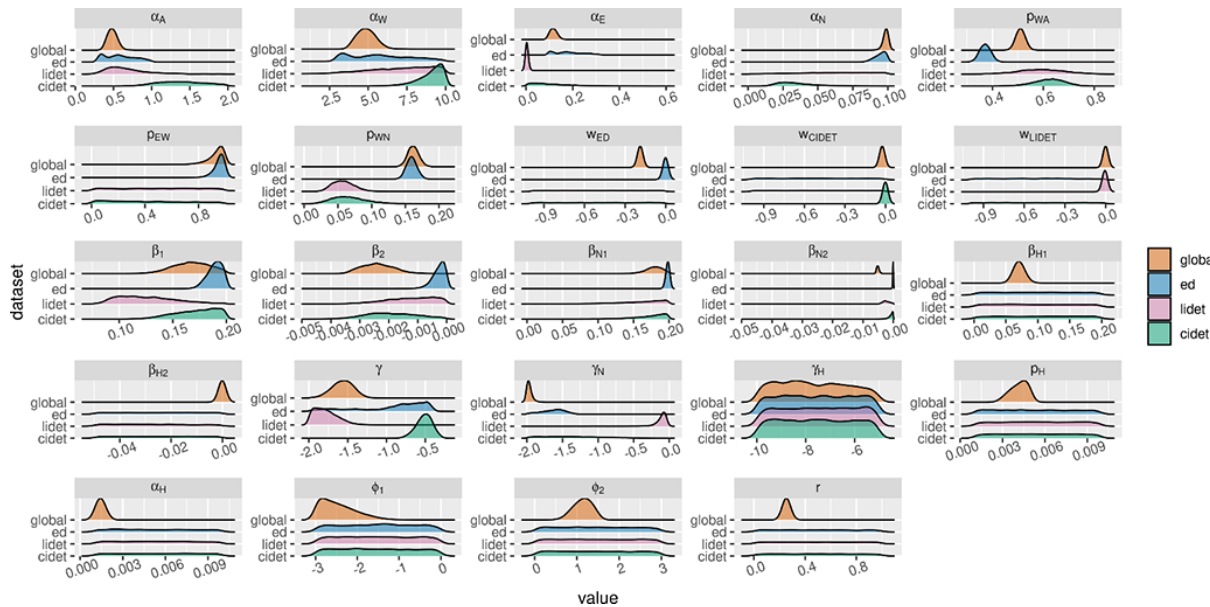
Figure 2. The estimated parameter distributions using DEzs with different calibration